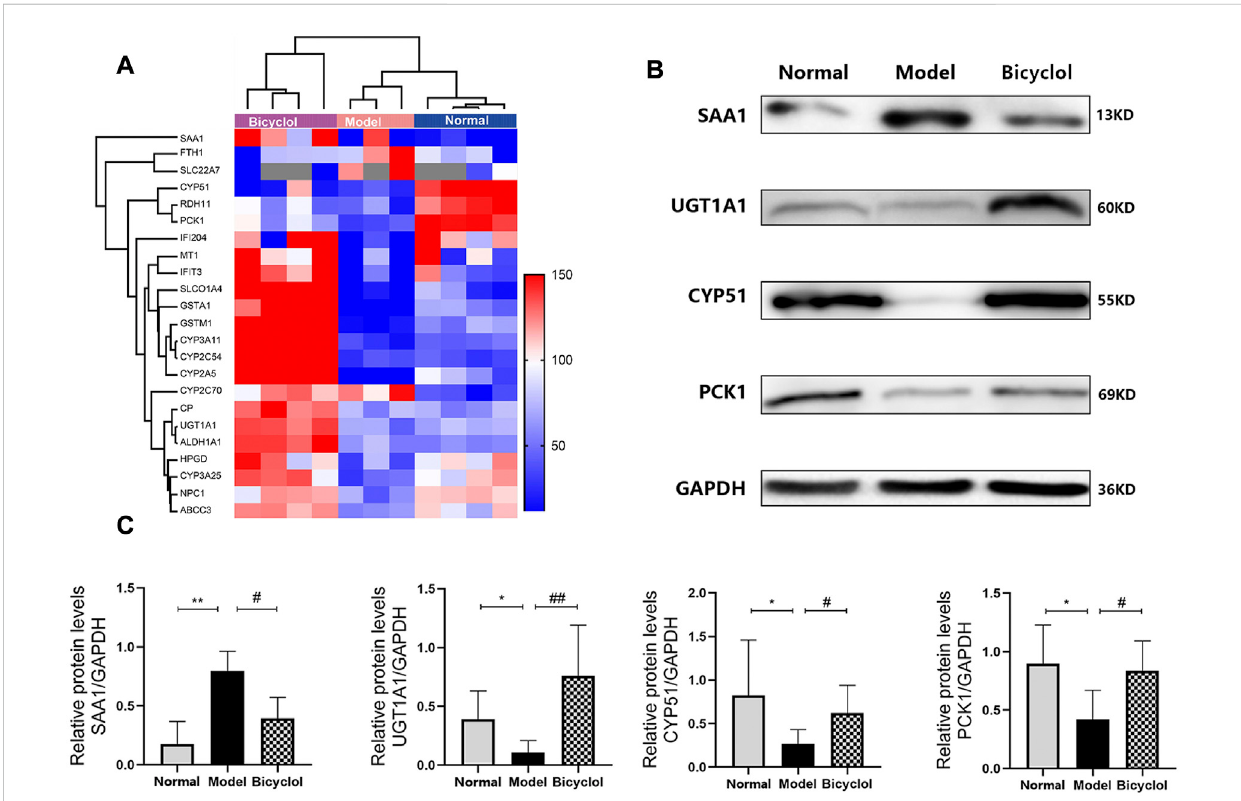
FIGURE 6 (A) Heatmapof theproteins involvedinin fl ammation, bile acid metabolism, cytochromeP450pathway andbiological processes. Blue andred colors indicate low and high proteins expression respectively. (B) Representative immunoblot images of SAA1, UGT1A1, CYP51, PCK1 and GAPDH. (C) Relative protein levels of SAA1 (n = 4), UGT1A1 (n = 4), CYP51(n = 4), PCK1(n = 5). * p < 0.05 vs Normal, ** p < 0.01 vs Normal, # p < 0.05 vs Model, ## p < 0.01 vs